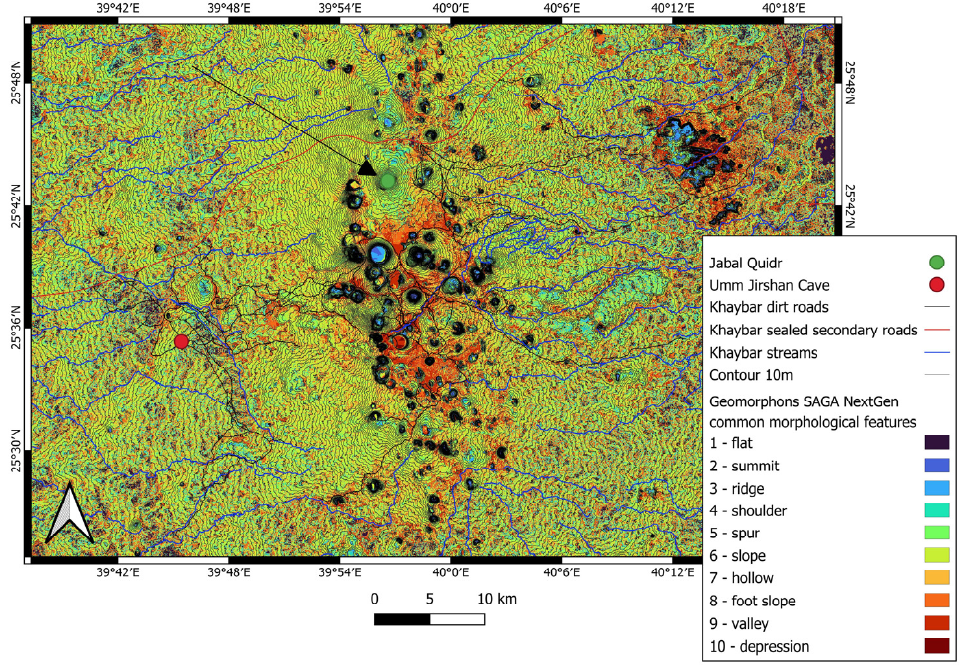
Figure 5. Geomorphon map of the central part of the fi eld, showing the gentle sloping region away from the dorsal ridge of the vents in the central regions. Contour intervals are 10 m. The arrow points to Jabal Quidr.